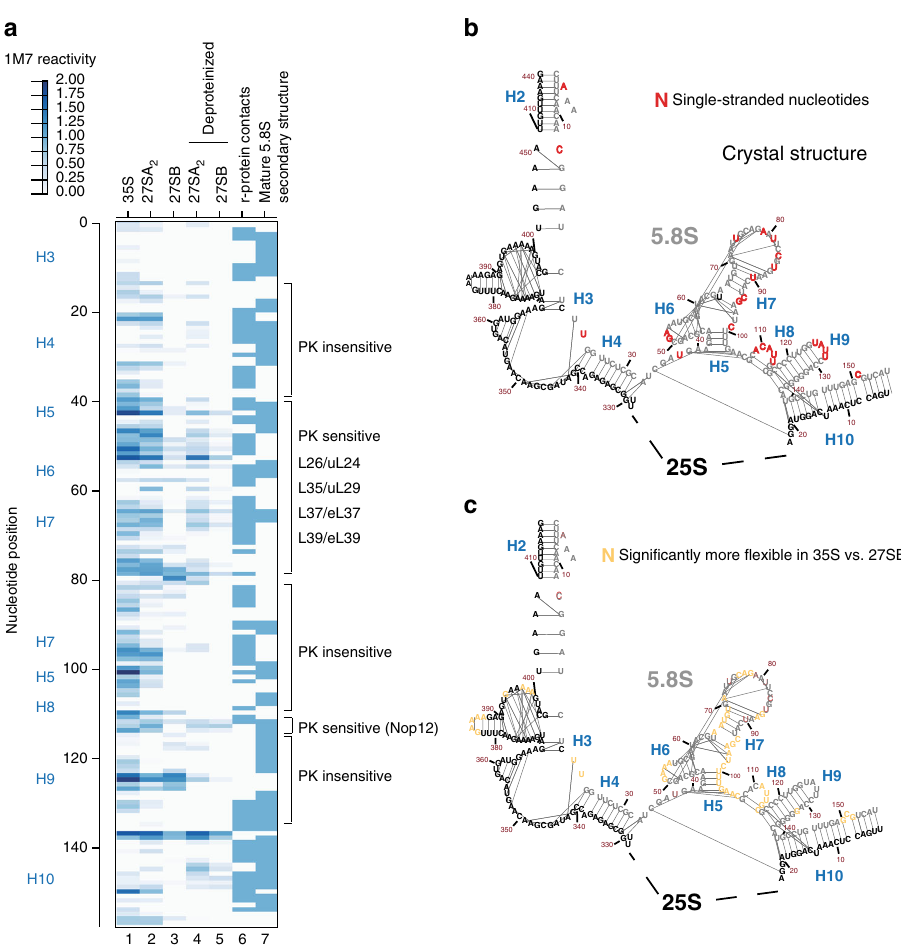
Fig. 5 The 5.8S region undergoes a major restructuring event during the conversion of 27SA 2 to 27SB pre-rRNA. a Heat map representing the ChemModSeq 1M7 reactivities. Each block indicates a single nucleotide, the darker the block the higher the 1M7 reactivity. The blue blocks in lane 6 indicate r-protein-binding sites 35 . Lane 7 represents the nucleotides that are base-paired ( blue blocks ) or single-stranded ( white blocks ) in the mature 5.8S rRNA crystal structure 35 . b Secondary structure of the 5.8S rRNA. Black lines indicate base-pairing interactions observed in the yeast 80S crystal structure. The red nucleotides are single-stranded in the crystal structure. c Overview of Δ SHAPE analysis in the 5.8S region. Yellow-colored nucleotides showed signi fi cantly higher SHAPE values in 35S compared to the 27SB particle